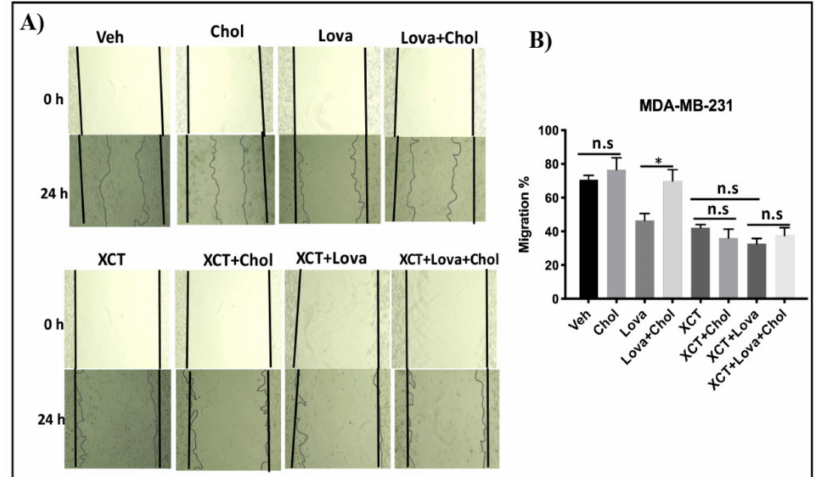
Figure 6. ( A ) Lovastatin decreases the migration of MDA-MB-231 cells, while cholesterol rescues the e ff ect of lovastatin, but not the e ff ect of XCT-790 using a scratch-wound migration assay, MDA-MB-231 cells were treated with vehicle(Veh), cholesterol (chol), lovastatin (Lova), Lovastatin + cholesterol (Lova + Chol), XCT-790 (XCT), XCT-790 + cholesterol (XCT + chol), XCT-790 + lovastatin (XCT + Lova) or XCT-790 + lovastatin + cholesterol (XCT + Lova + Chol), all at 5 µ M. Wound closure was monitored at 0 and 24 h, and representative images are provided. ( B ) Migration percentages were calculated as follows: migration % = ( T 0 h scratch width − T 24 h scratch width / T 0 h scratch width) × 100. The results represent 3 independent experiments. A value of p < 0.05 was considered significant